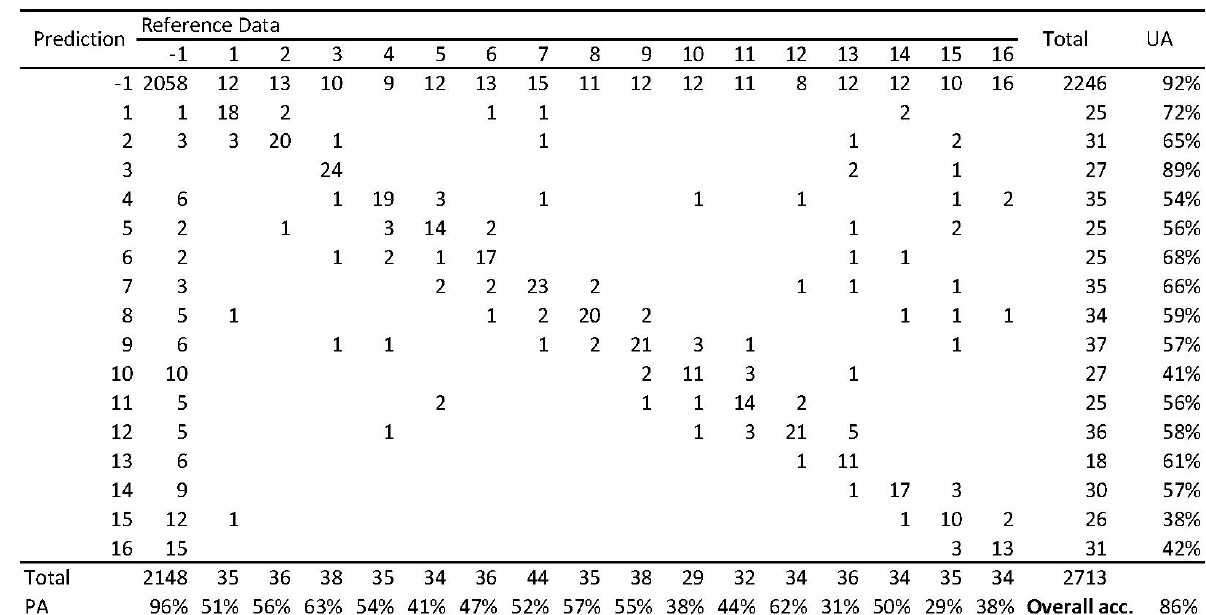
Figure A3. Count-based confusion matrix for Global Forest Change Version 1.4 data set. Reference data and prediction class values represent the last disturbance year (e.g., 01 = year 2001). The −1 class represents the undisturbed class. UA = user’s accuracy. PA = producer’s accuracy.